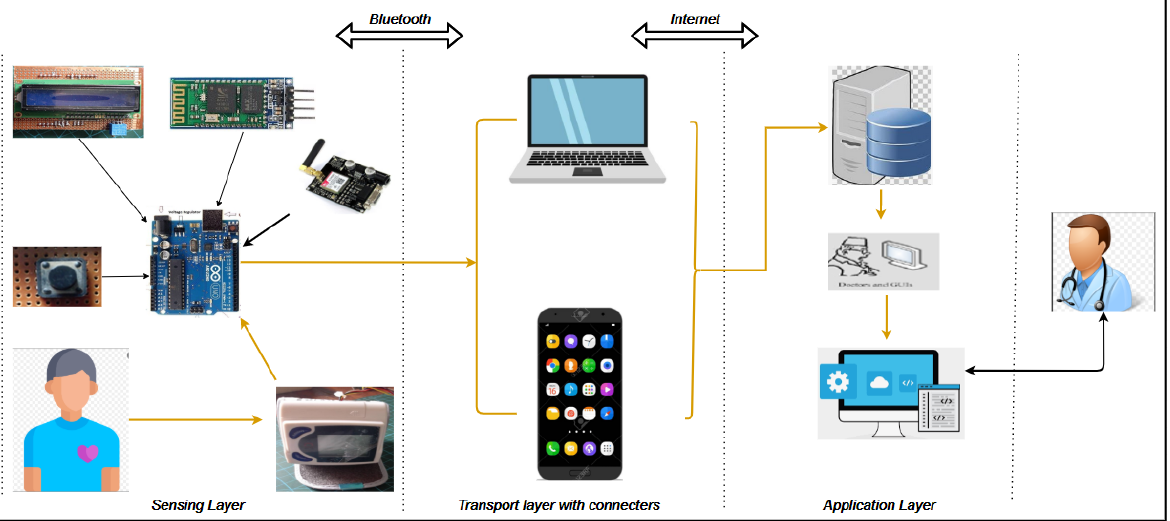
Figure 2. System architecture of the cardiovascular RPM system.